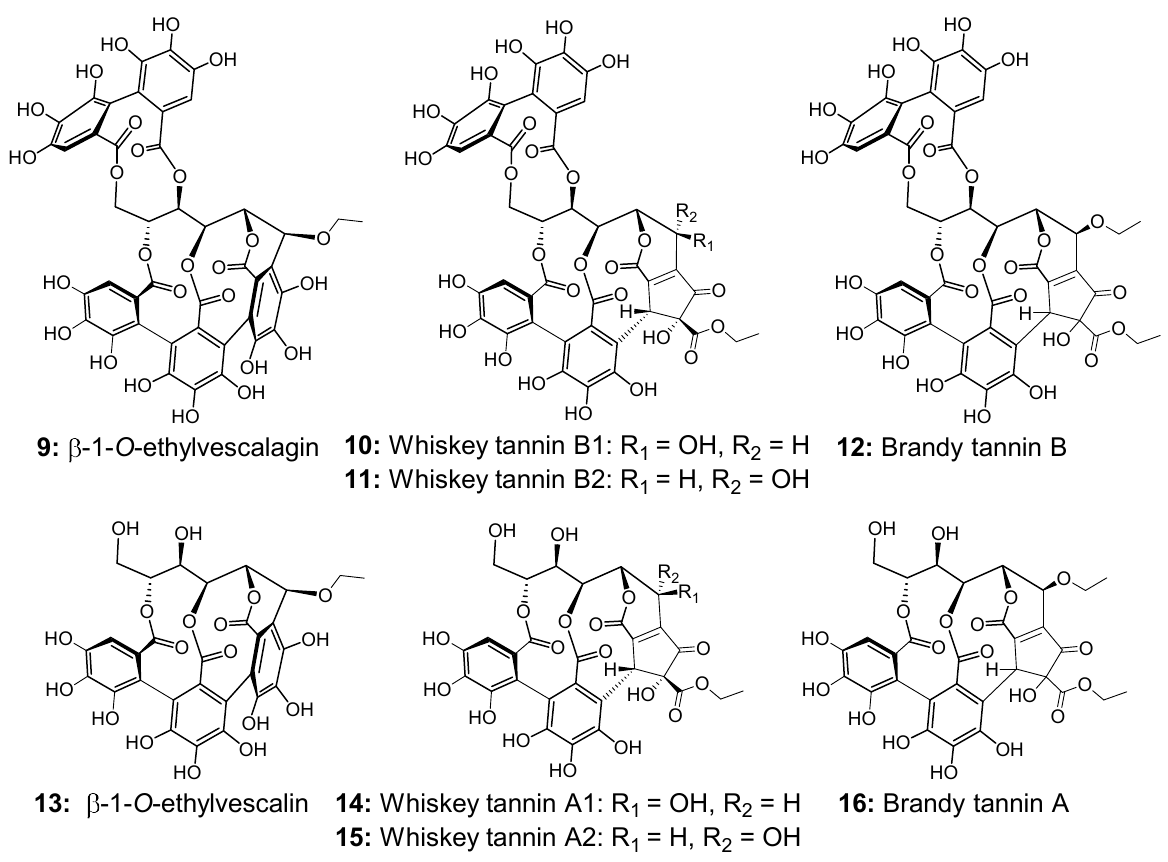
Figure 2. Structure of ellagitannin-derived spirit compounds ( 9 – 12 ) and their hydrolysis form ( 13 – 16 ) identified and quantified in cognac eau-de-vie aged in contact with oak wood.